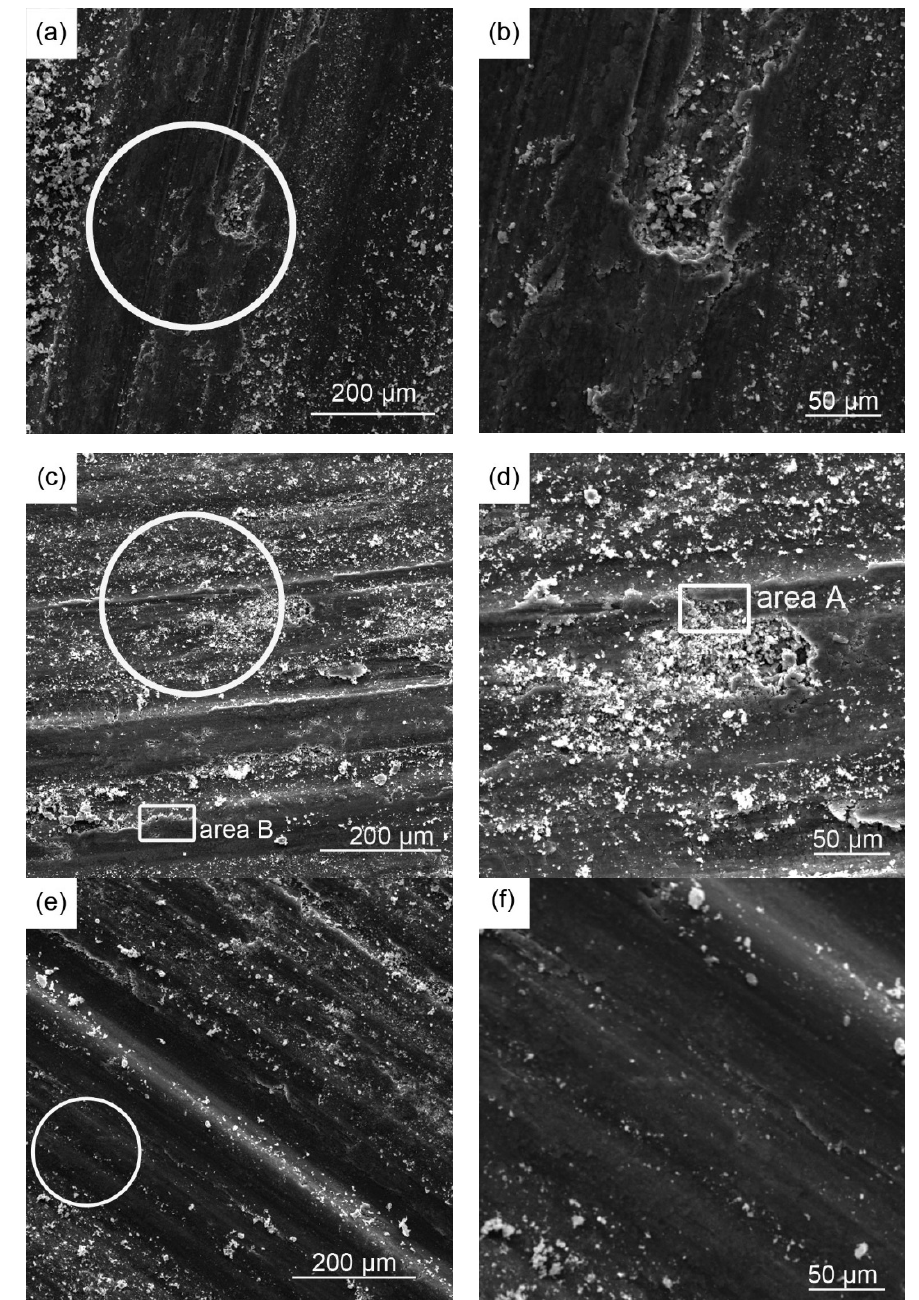
Figure 10. SEM images of samples under a normal load of 90 N at sliding speed of 0.188 m/s. ( a , b ) Al ‐ 5Si ‐ 1Cu ‐ 0.5Mg alloy, ( c , d ) SiCp/Al ‐ 5Si ‐ 1Cu ‐ 0.5Mg composites before T6 treatment and ( e , f ) after T6 treatment.